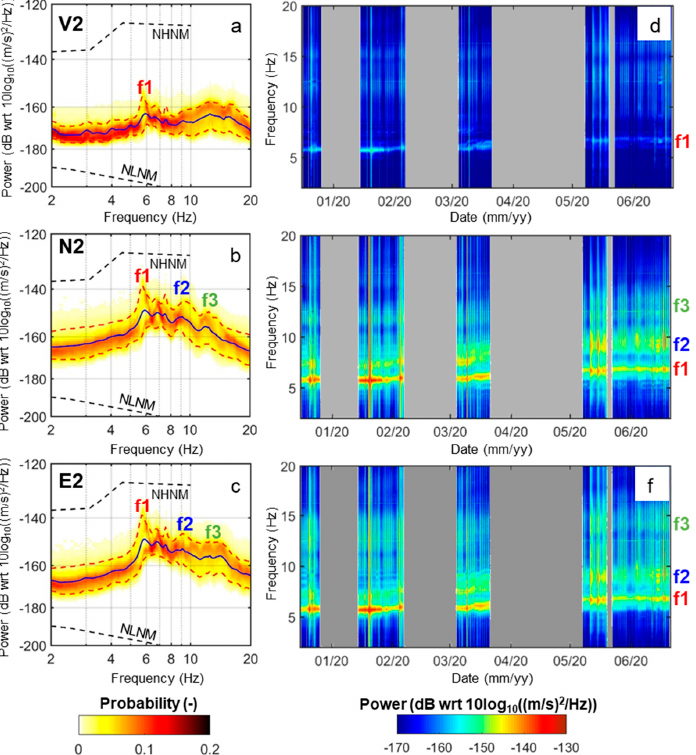
Figure 4. Spectral analysis of ambient seismic noise recorded at S2 (tower top). ( a – c ) PDFs of the hourly PSDs, with average (blue line) and 10th–90th percentiles (red dashed lines): ( a ) Vertical, ( b ) North and ( c ) East component. Dashed black lines: NHNM and NLNM boundaries [20]. ( d – f ) Hourly PSDs over the monitored period: ( d ) Vertical, ( e ) North and ( f ) East component. The main spectral peaks are highlighted with f1 to f3. No data periods are shaded in gray. Remote Sens. 2021 , 13 , x FOR PEER REVIEW